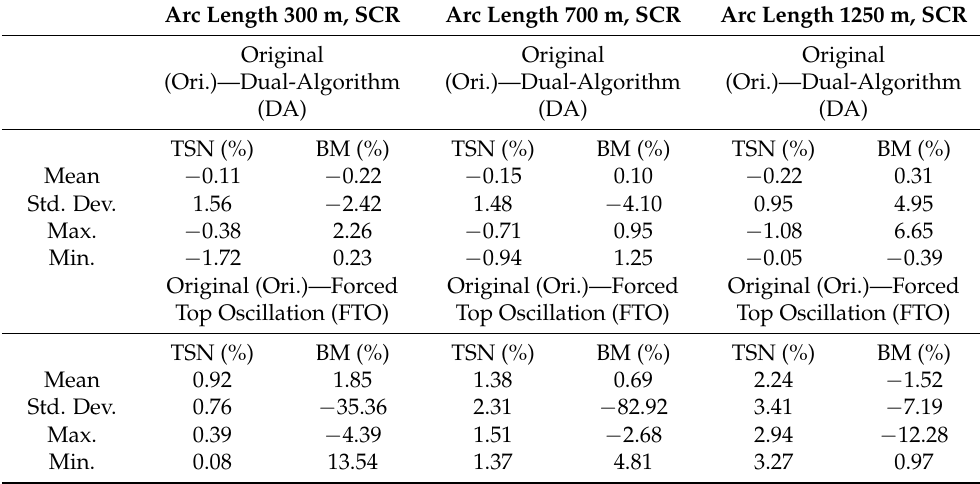
Table A2. Error Comparison: Original vs. Dual-Algorithm (DA) or FTO, 100-yr storm, WD1000,